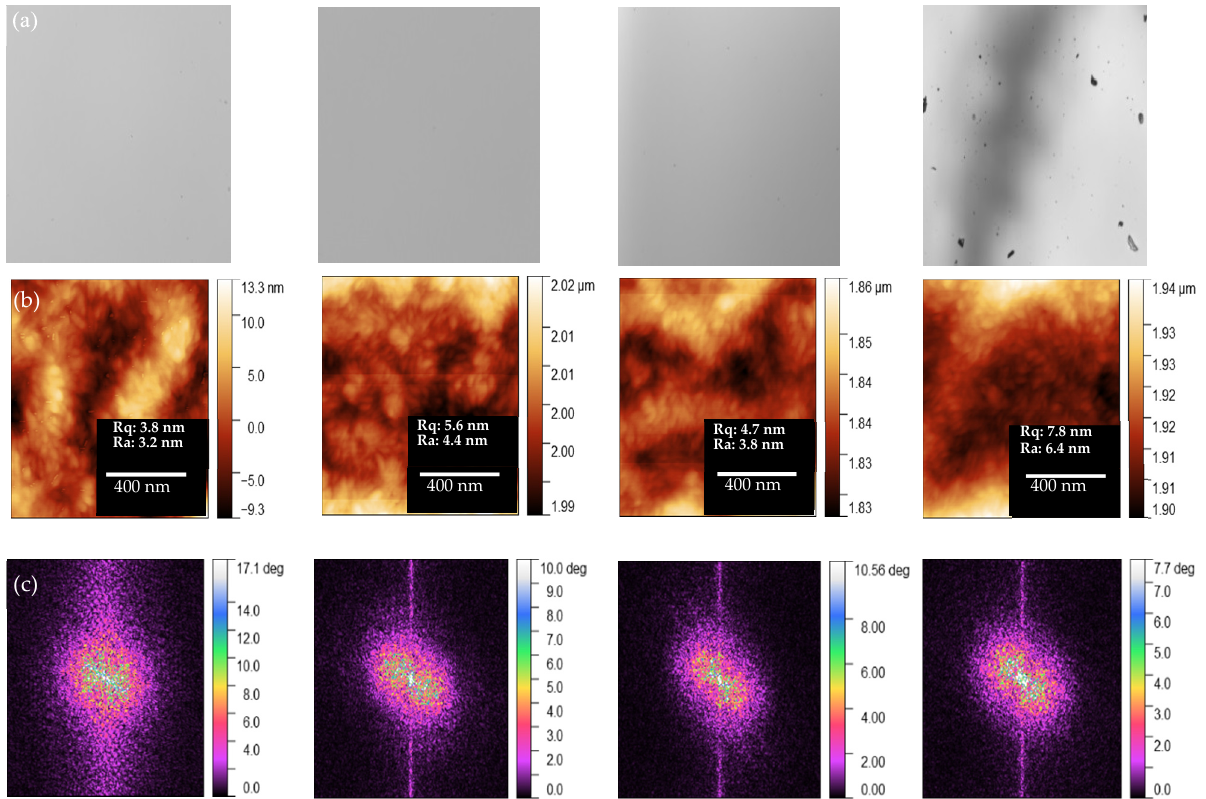
Figure 3. ( a ) OM images, ( b ) topographical and ( c ) 2D-FFT–converted AFM images of the blend films.